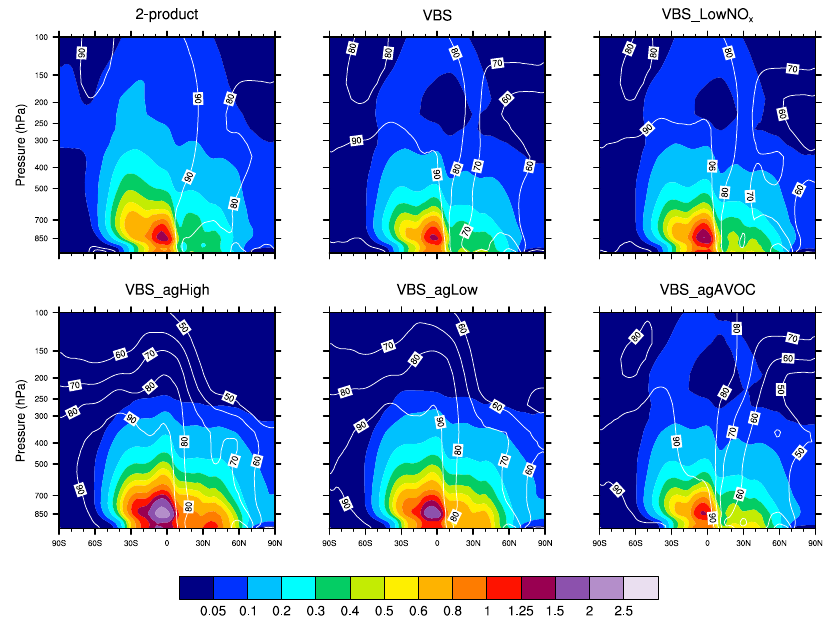
Figure 1. Annual mean zonally averaged SOA concentration (µgm − 3 ) (shown as colored shades) and the fraction of biogenic SOA (%) (shown as white contours) in CAM4-chem for different SOA treatments. Table 3. Summary of simulated annual mean global budget of SOA (particle-phase).